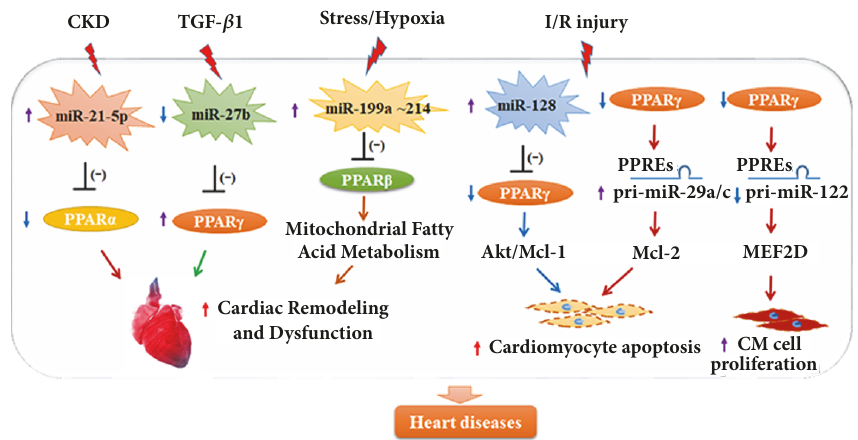
Figure 3: The regulatory function of microRNAs/peroxisome proliferator-activated receptors (PPARs) axis in cardiomyocyte apoptosis, and cardiac remodeling and dysfunction. CKD: chronic kidney disease; TGF- 𝛽 1: transforming growth factor 𝛽 1; I/R: ischemia/reperfusion; Akt: serine/threonine kinase 1;Mcl-1:myeloid leukaemiacelldifferentiation protein-1; Mcl-2:ananti-apoptotic Bcl-2 familymember; MEF2D: myocyte enhancer factor 2D. CM: cardiac